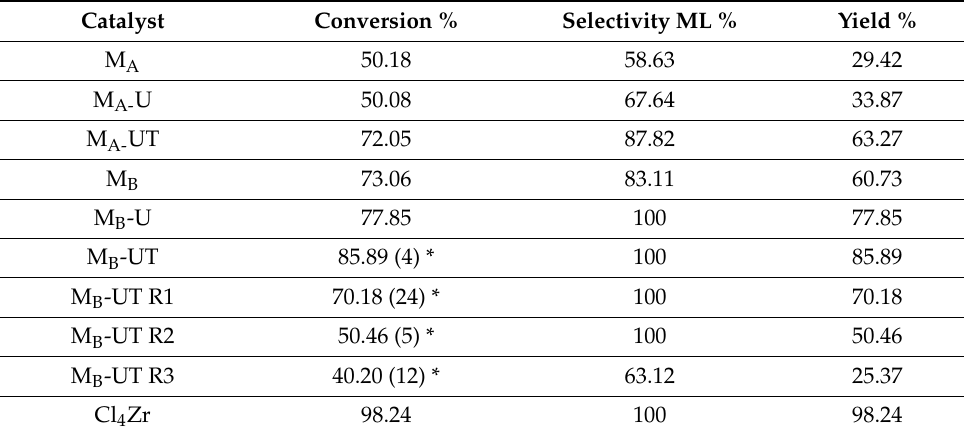
Table 9. Catalytic activity. T = 130 ◦ C, P = 30 bars, 0.05 g catalyst.